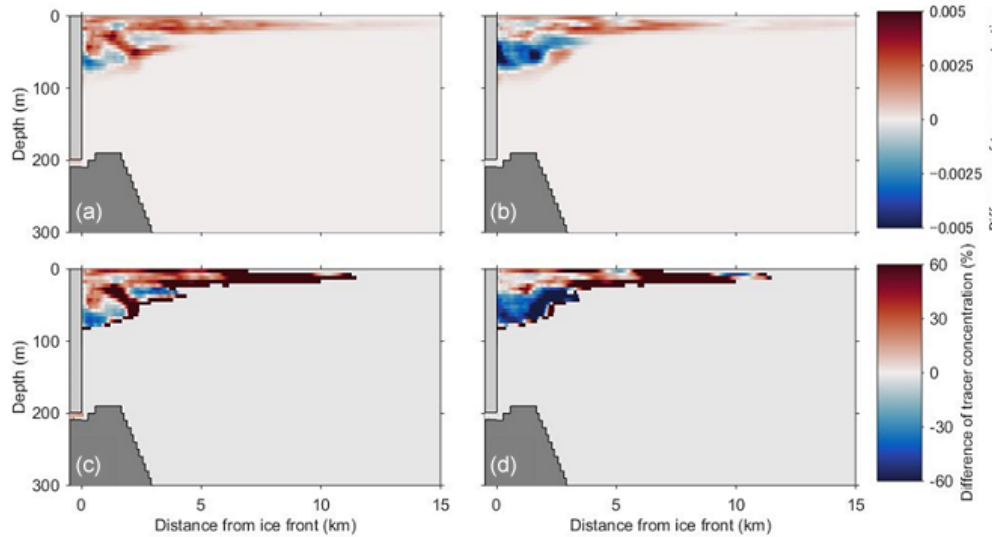
Figure 10. (a) Cross-fjord averaged difference between subglacial discharge tracer concentrations for Q45 ( Q sg = 45m 3 s − 1 ) and CTRL ( Q sg = 36m 3 s − 1 ) using the same initial stratification conditions. The difference after integration for 41h is shown. (b) Difference between the results for the same amount of discharge using initial stratifications as observed in 2016 and 2014 (ST16–CTRL). (c) and (d) Percentage of the results in (a) and (b) , respectively.